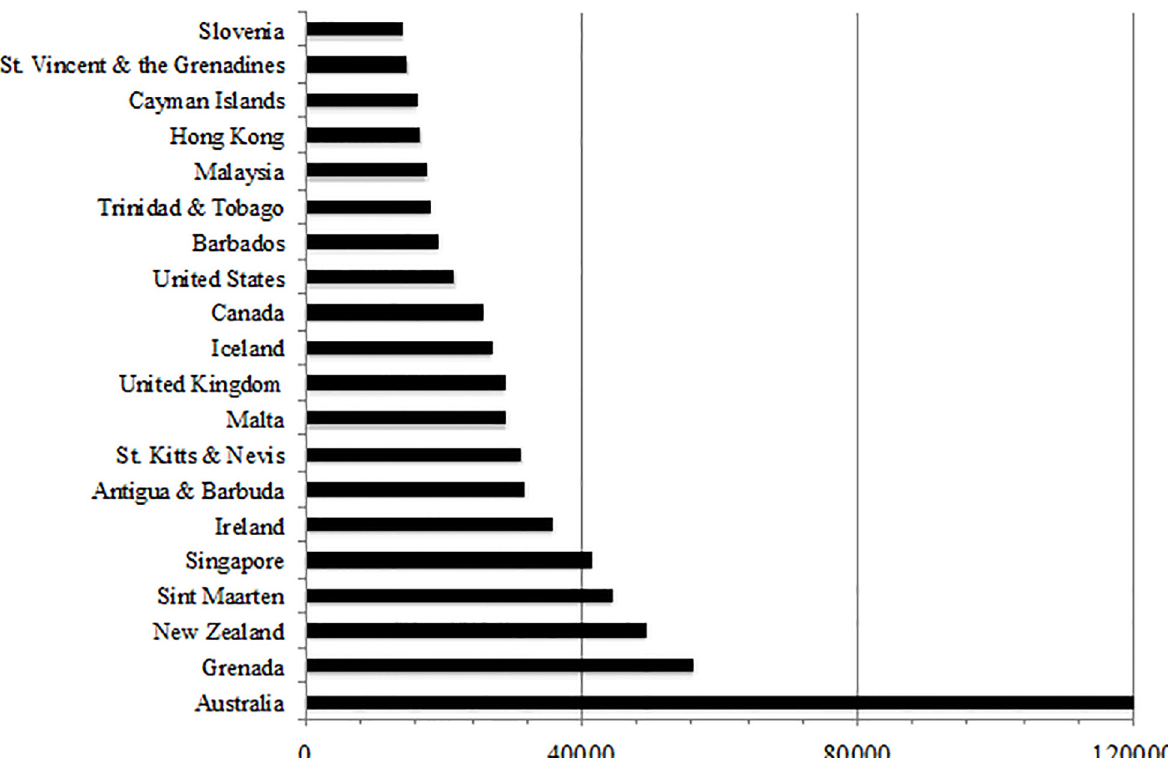
Figure 3. Population-weighted session counts from FOAM users in the top 20 countries, 2016 (per million people). FOAM , Free Open Access Medical